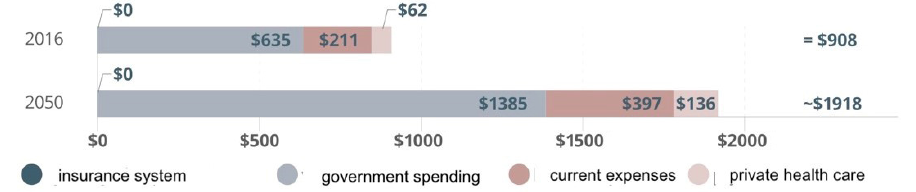
Figure 1. Healthcare spending by type. Prepared by: A. Gawlak, based on: Financing Global Health Database 2018/Financing Global Health Database, http://www.healthdata.org/policy-report/financ-